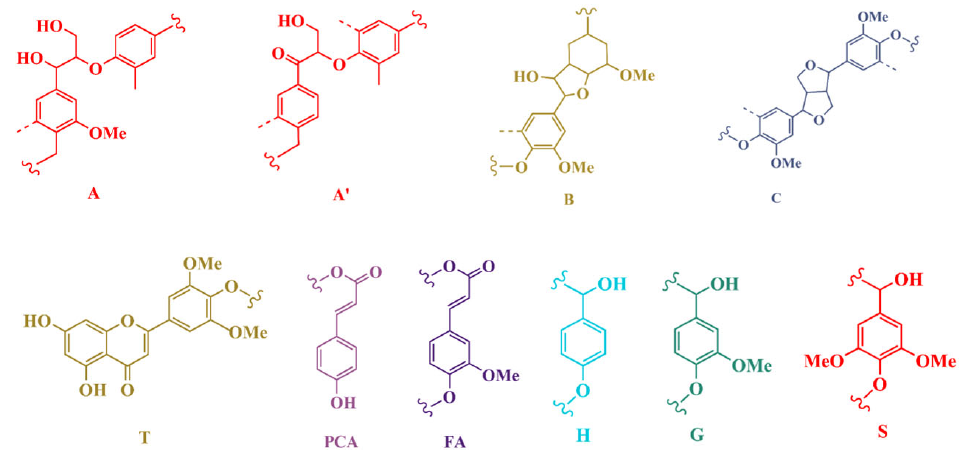
Figure 6. Main substructures observed in MWL and DES ‐ Ls by 2D HSQC: ( A ) β‐ O ‐ 4 ′ ether linkages, ( A’ ) β‐ O ‐ 4 ′ ether linkages with, acetylated at γ‐ carbon, ( B ) resinol, ( C ) phenyl ‐ coumaran, ( PCA ) p ‐ coumarate acid, ( FA ) ferulic acid, ( T ) flavone tricin, ( H ) p ‐ hydroxyphenyl units, ( G ) guaiacyl units, ( S ) syringyl units.